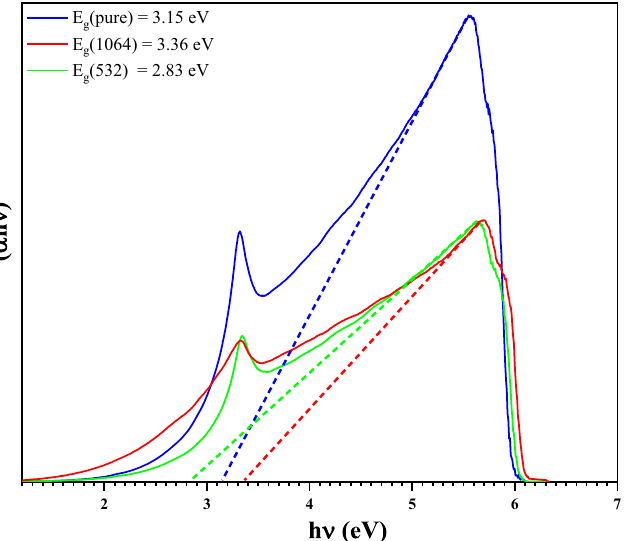
Figure 10. Tauc plot for ZnO NPs before (blue line) and after irradiations (red and green line).